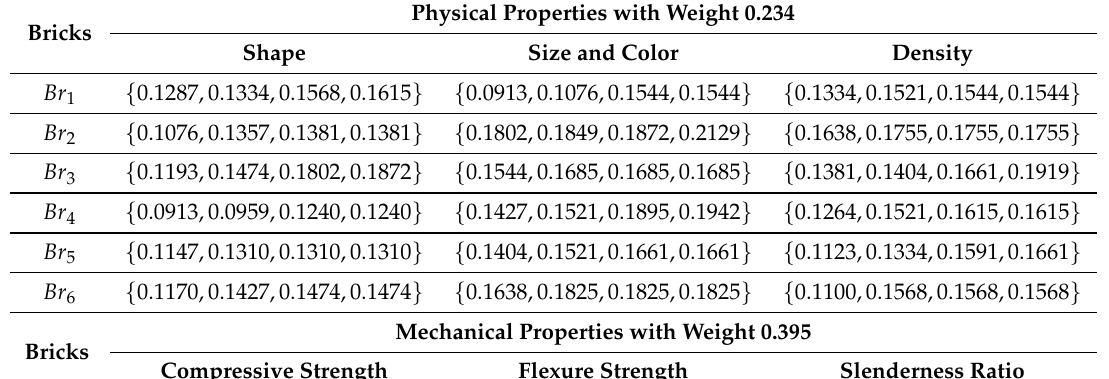
Table 4. Tabular representation of weighted optimistic 3HF decision matrix.